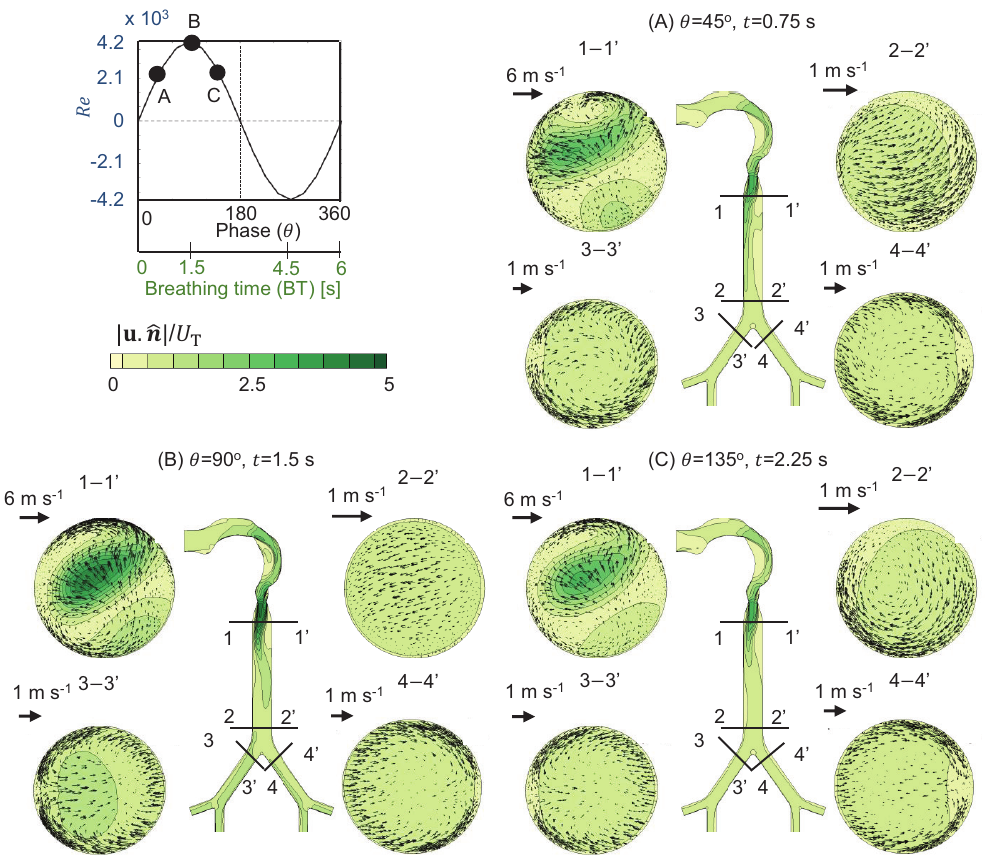
Figure 7. Contours of magnitude of the plane-normal velocity component (non-dimensionalized with mean flow speed in trachea, U T ) with superimposed in-plane velocity vectors for Planes 1–4 at various time-points during inhalation for Wo = 2.41 at IT/BT = 50%. A is at Phase θ = 45 ◦ (=25% IT), B is at Phase θ = 90 ◦ (=50% IT), and C is at Phase θ = 135 ◦ (=75%